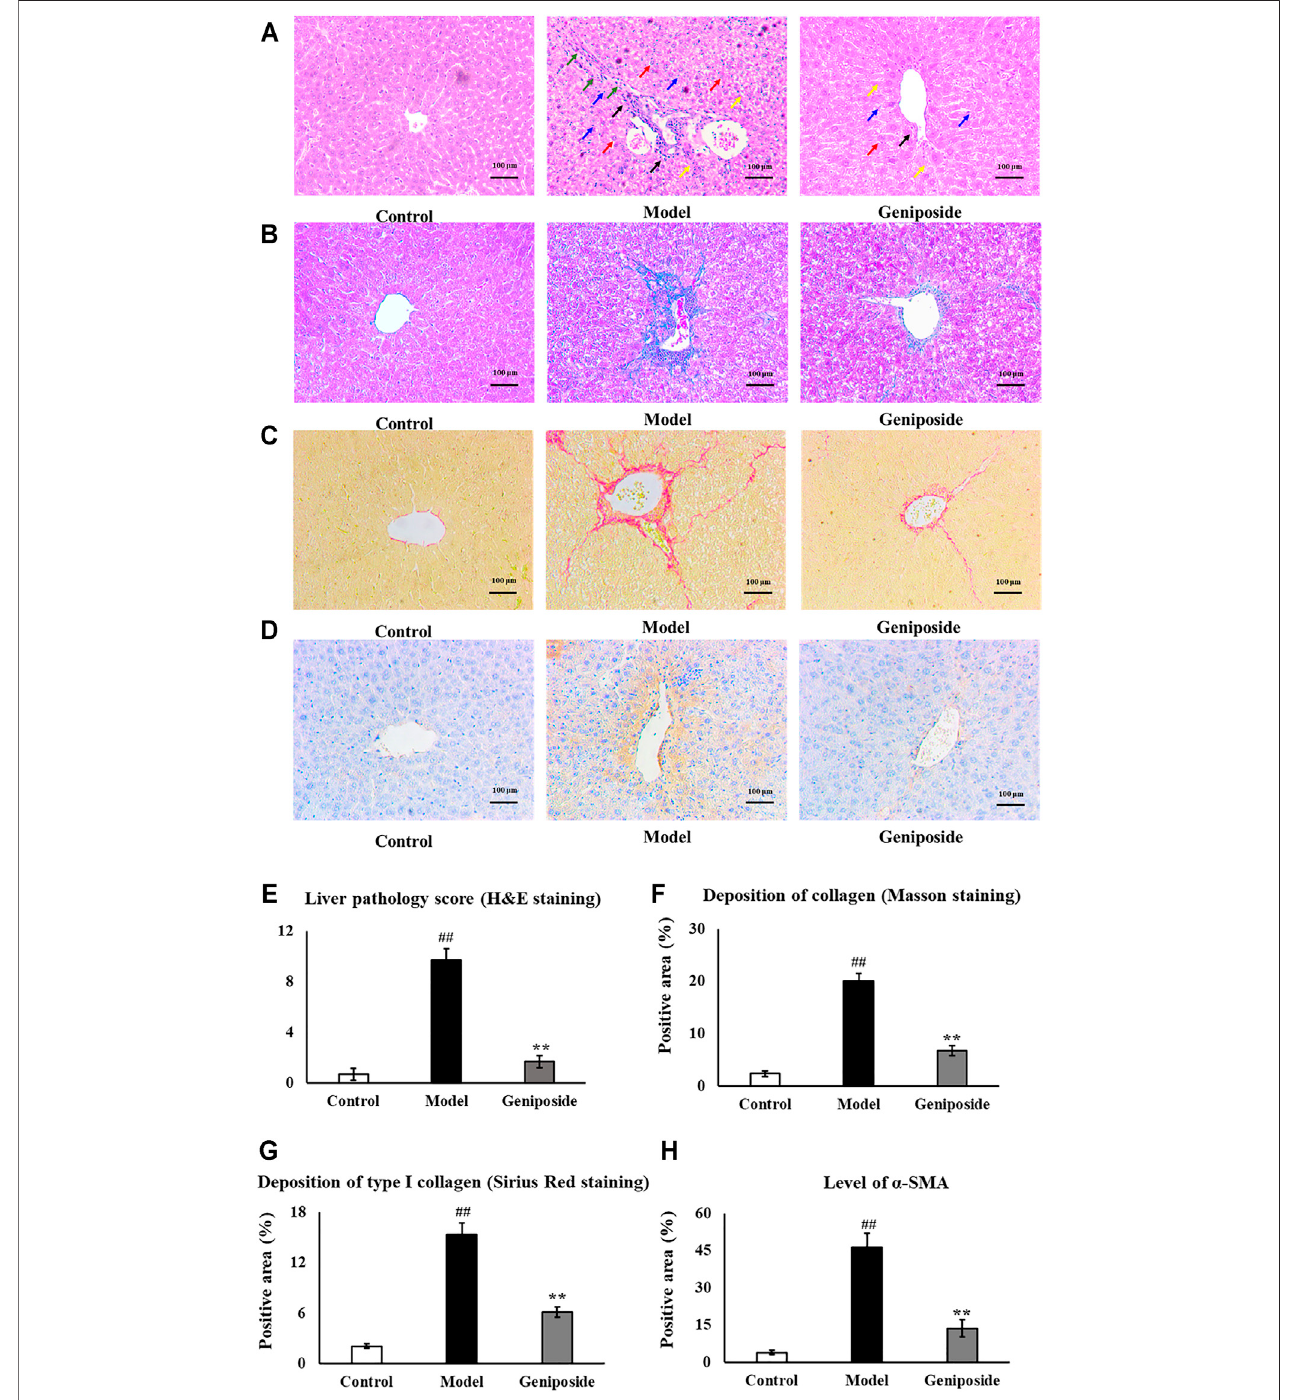
FIGURE 3 | Evaluation of liver histopathology. (A,E) H&E staining and liver pathology score showed that geniposide treatment improved pathological changes in the liver. Black arrows indicate in fi ltration of in fl ammatory cells. Yellow arrows indicate structural disorder of the hepatic cord. Red arrows indicate swelling of the liver cells. Blue arrows indicate necrosis of the liver cells. Green arrows indicate fi brosis. (B,F) Masson staining showed that geniposide treatment could reduce collagen deposition in the liver. (C,G) Sirius Red staining showed that geniposide treatment reduced liver type Ⅰ collagen deposition. (D H) Immunostaining showed that geniposidetreatmentcoulddecrease α -SMAlevelsintheliver(100 × ).Control,model,andgeniposidegroups( n (cid:2) 10pergroup).Dataarepresentedasmean ± SD. ## p < 0.01, Model group vs. Control group; pp p < 0.01, Geniposide group vs. Model group.